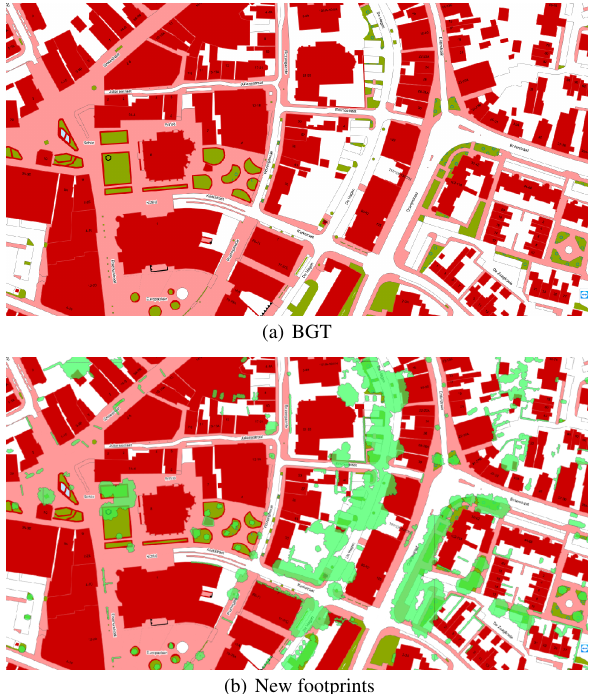
Figure 11. Comparison of the Basisregistratie Grootschalige Topografie (BGT) base map and Voortman’s work results. (Voortman,